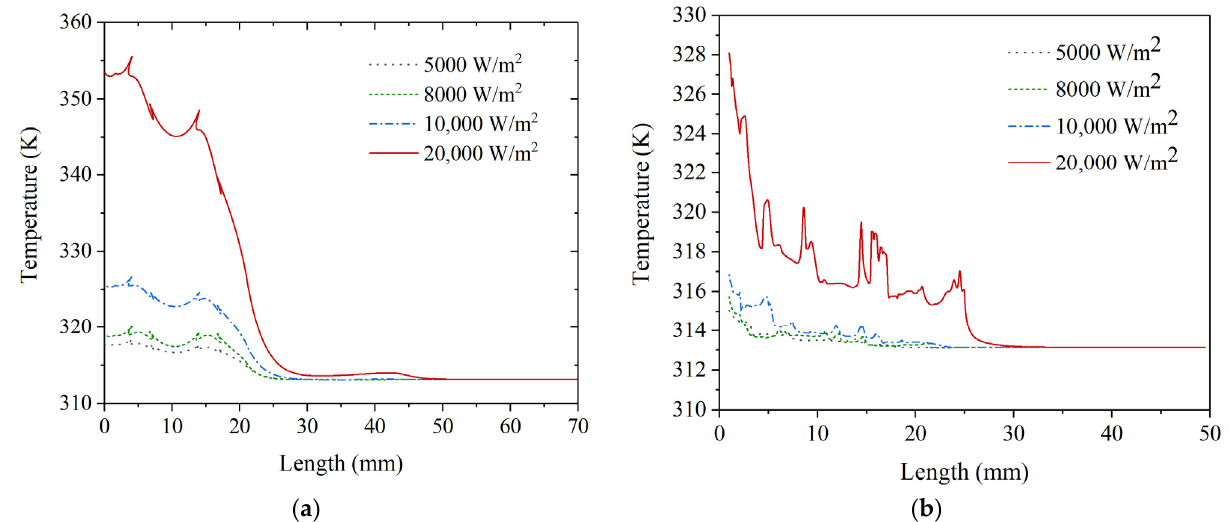
Figure 12. Temperature distribution along: ( a ) the outer wall; ( b ) the center line under different heat input.